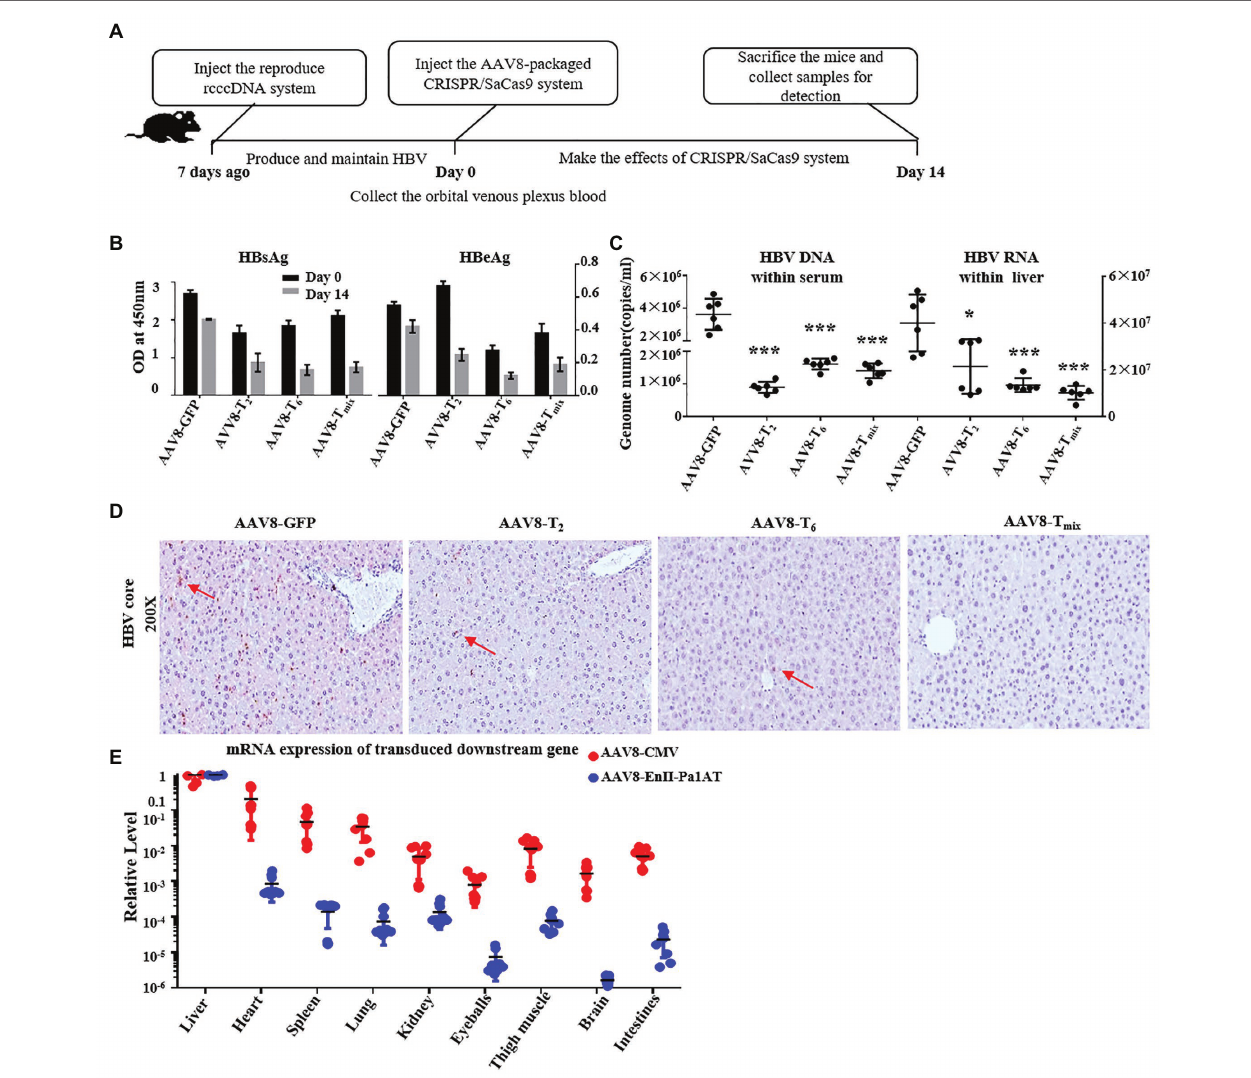
FIGURE 5 | Anti-HBV effects of the CRISPR/SaCas9 system with the EnhII-Pa1AT promoter in vivo . (A) The mice were divided into four groups and subjected to hydrodynamic injection (HDI) with the reproduce rcccDNA system plasmids. At 7 days post-injection, we injected the adeno-associated virus (AAV)8-packaged CRISPR/SaCas9 system into the mice via the tail vein again. After two injections, blood samples were collected on day 0, and the mice were sacrificed on day 14. (B) The levels of HBsAg and HBeAg were measured using ELISA. (C) HBV DNA in the sera was measured using qPCR and HBV RNA in the liver was measured using RT-qPCR. (D) Immunohistochemical staining for HBcAg was performed in the liver. (E) Nine tissue samples were collected from twice injected mice as mentioned above, eGFP mRNA and SaCas9 RNA were measured using RT-qPCR. The results of the ELISA and qPCR were calculated from three independent experiments, and the data are presented as the mean ± SEM. * p < 0.05 and *** p < 0.001. T mix , the mixture of AAV8-T 2 and AAV8-T 6